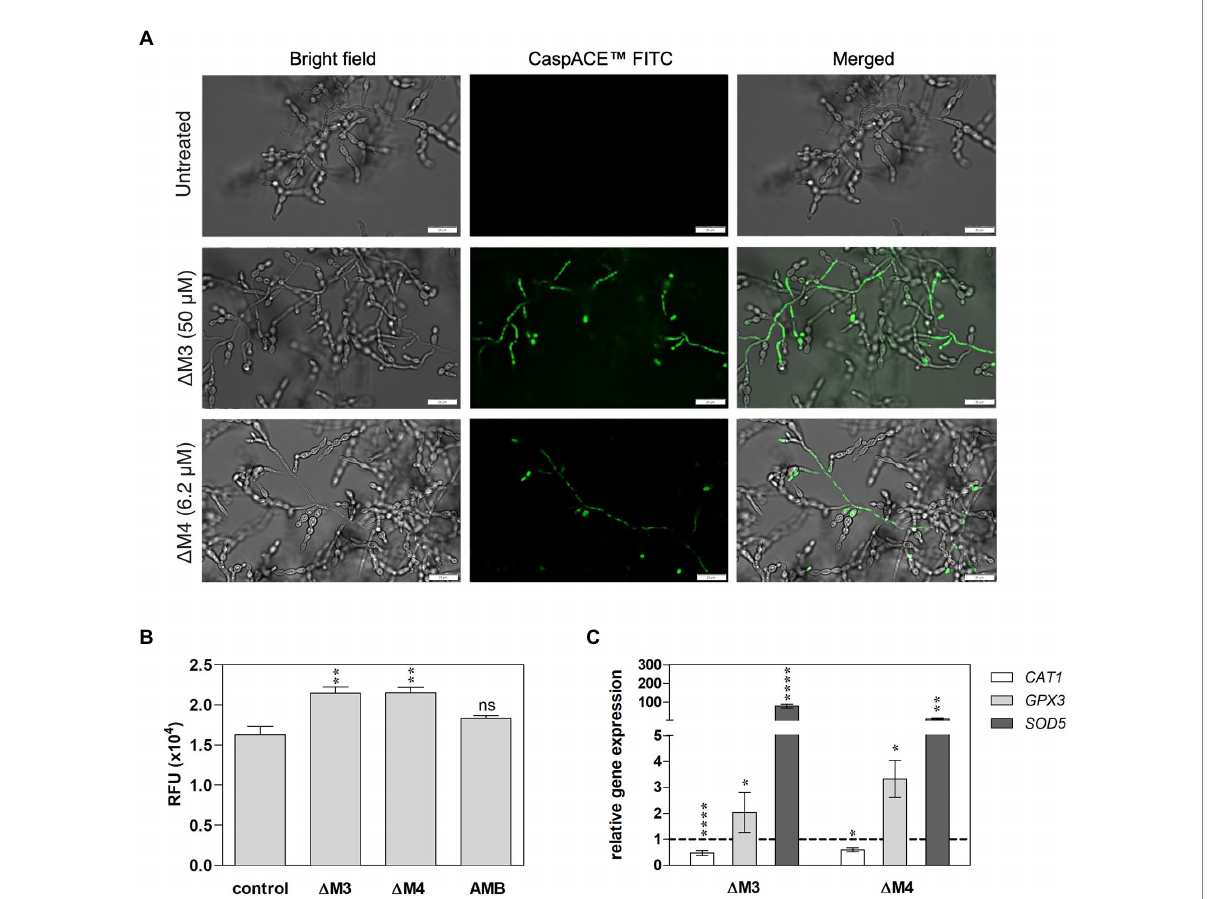
FIGURE 7 Apoptotic response and oxidative stress induced by Δ M3 and Δ M4 in C. albicans mature biofilm. (A) C. albicans cells (10 5 /ml) were seeded in a 96-well plate and biofilms were grown for 24 h, then peptides were added to the cells in the concentration range of 12.5–100 μ M ( Δ M3) or 3.1– 12.5 μ M ( Δ M4). The biofilm was grown in the presence of peptides for a further 24 h. The CaspACE ™ FITC-VAD-FMK In Situ Marker kit was used to assess metacaspase activation. The marker (10 μ M) was added to the biofilms and incubation was carried out for 1 h at 37 ° C. Biofilms were imaged with an Olympus IX73 microscope and representative images for Δ M3 (50 μ M) and Δ M4 (6.2 μ M) are presented. (B) Intracellular ROS production in mature biofilm by peptides was evaluated with DHR test. The 24-h C. albicans biofilms were treated with Δ M3 (50 μ M), Δ M4 (6.2 μ M) and amphotericin B (2.7 μ M) for 3 h at 37 ° C, washed with PBS and then incubated with DHR 123 (10 μ M) for 30 min. The untreated C. albicans biofilm served as a control. The fluorescence of oxidized DHR 123 was measured using the BioTek Synergy H1 microplate reader. The graphs present values as mean ± SD ( n = 3), RFU- relative fluorescence units. Statistical analysis was performed with one-way ANOVA with Dunnett’s multiple comparisons post-hoc test. ** p < 0.01 (C) Analysis of CAT1 , GPX1, and SOD5 gene expression was performed in mature biofilm cells treated